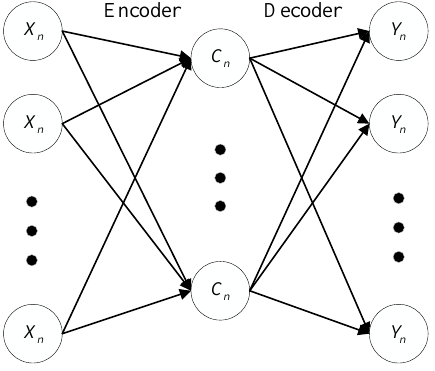
Figure 4. The structure of the